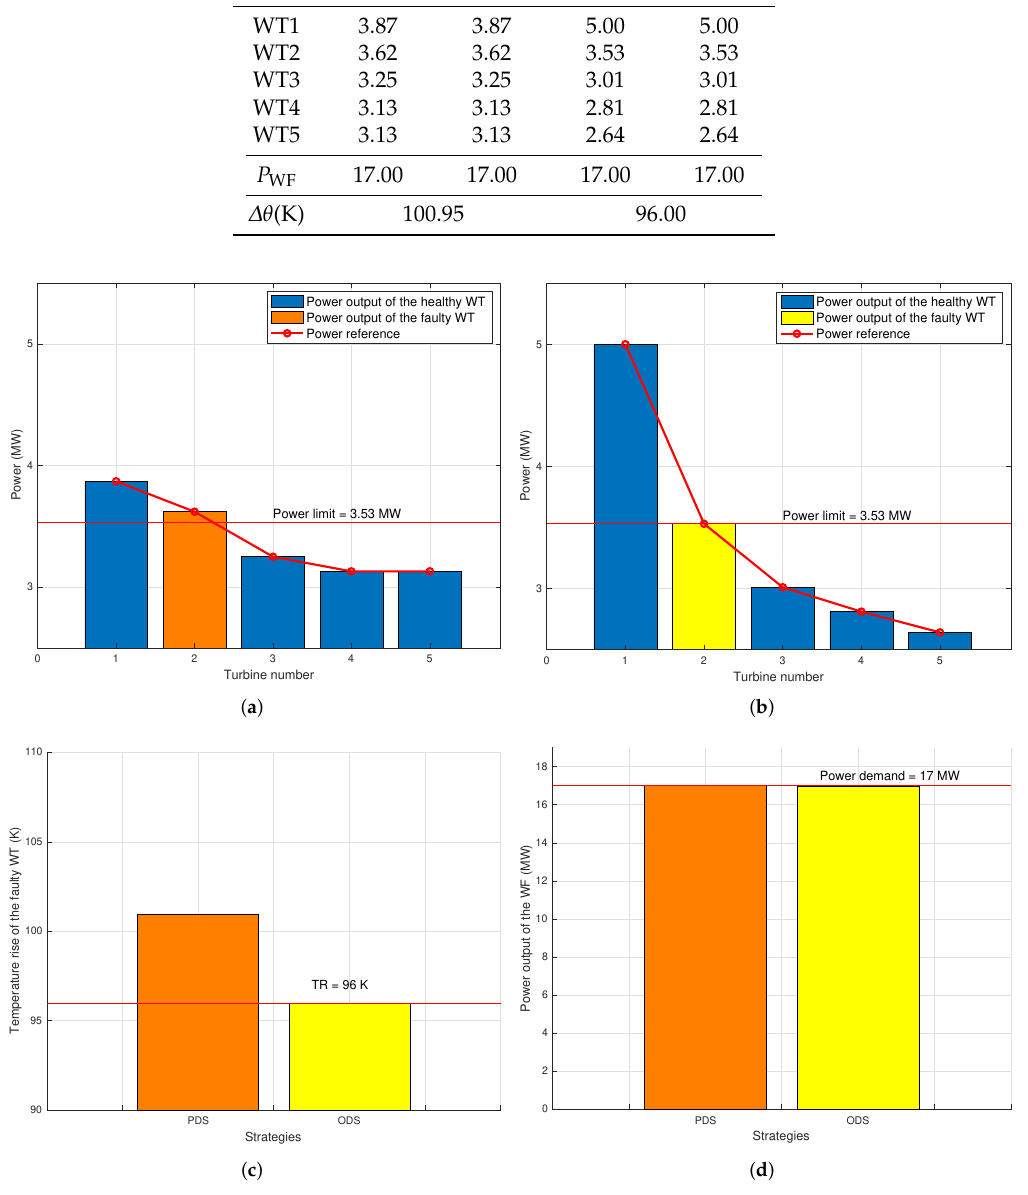
Figure 13. Comparison of power and temperature rise in Case 3, M1: ( a ) power reference and power output in PDS; ( b ) power reference and power output in ODS; ( c ) temperature rises of the faulty WT in PDS and ODS; ( d ) power output of the